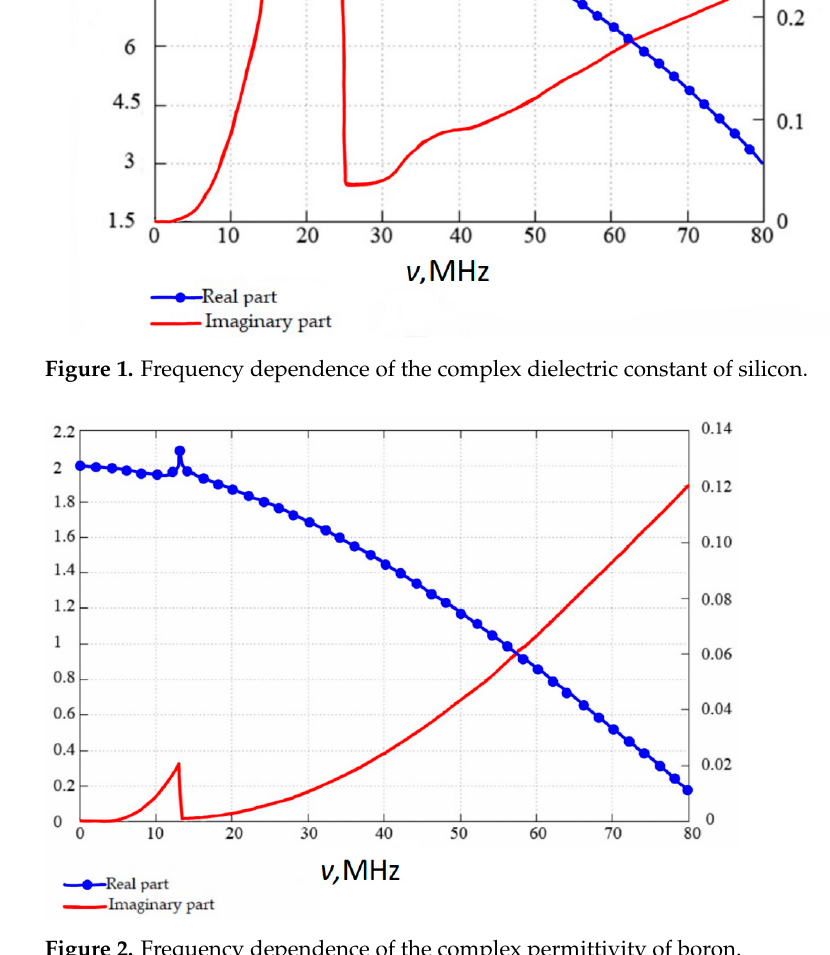
Figure 2. Frequency dependence of the complex permittivity of boron.